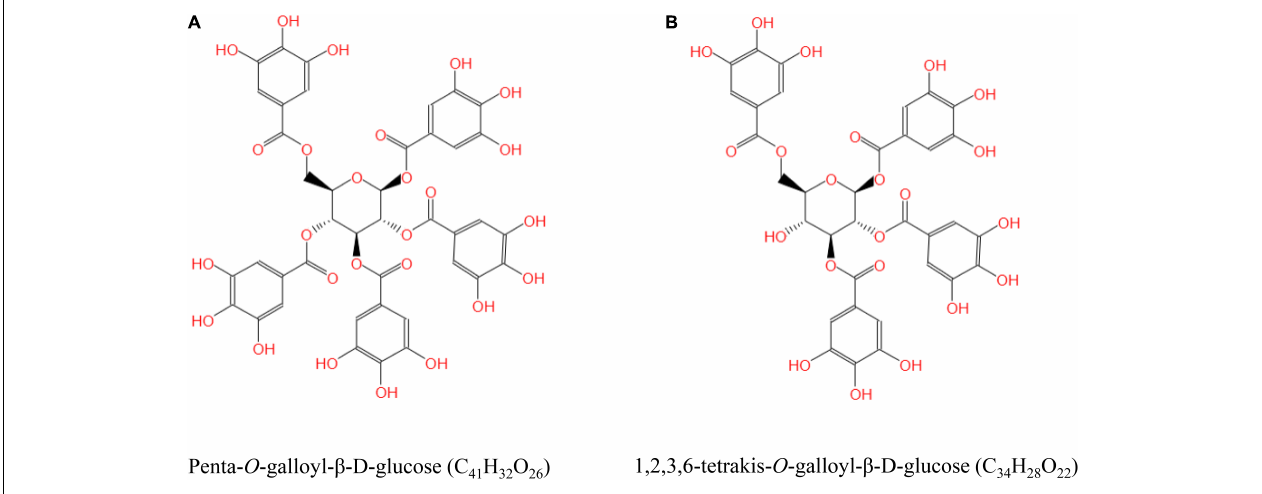
FIGURE 1 | The structural formula of tannic acid (TA). Penta- O -galloyl- β -D-glucose (C 41 H 32 O 26 ) (A) and 1,2,3,6-tetrakis- O -galloyl- β -D-glucose (C 34 H 28 O 22 ) (B) .